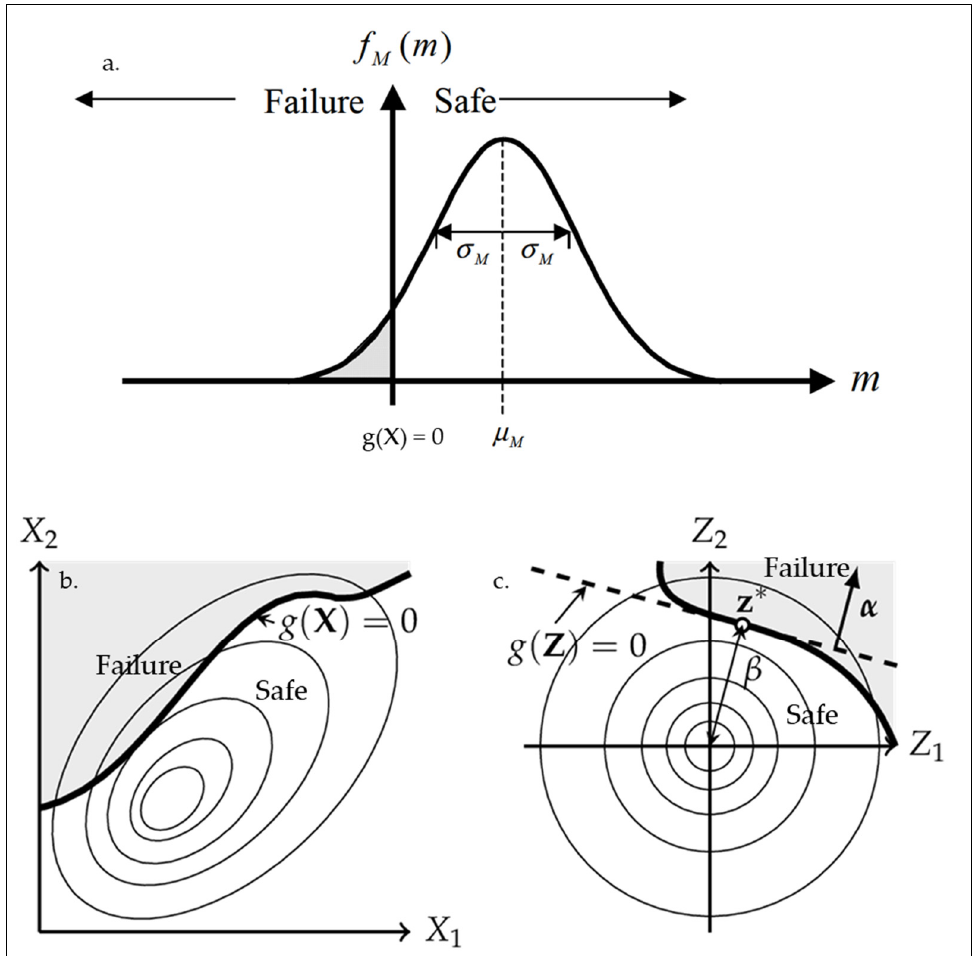
Figure 6. ( a ) Gaussian distribution of the probability distribution function of safety margin M showing the g(X) = 0 line, which defines the failure and safe events (modified after Faber [54]), ( b ) limit-state function g(X) stated in the physical space using two random variables (X 1 and X 2 ), and ( c ) after normalization to zero average with the design point z* and reliability index β (modified after Madsen et al. [55]).